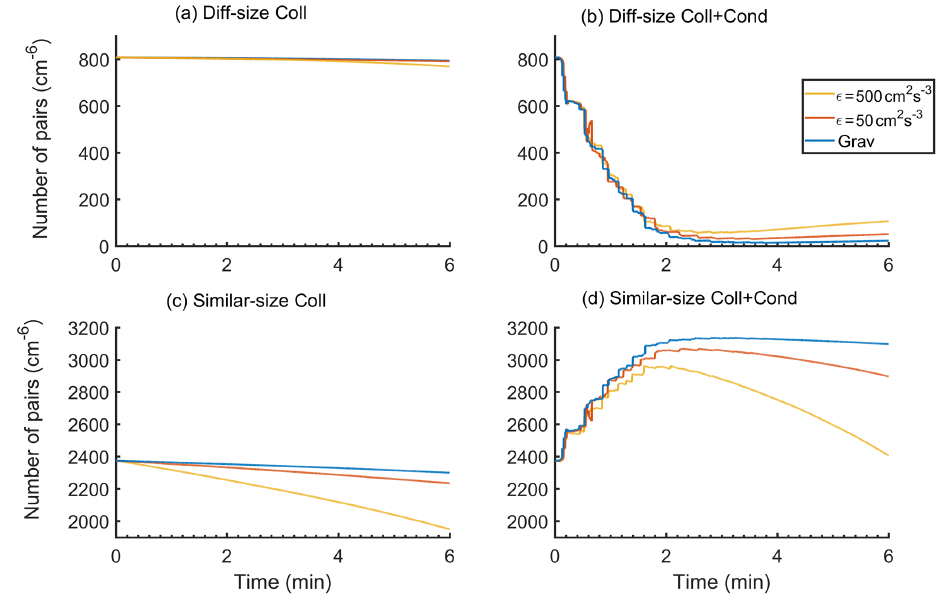
Figure 5. Time evolution of the number of pair combinations for (a) the different-sized droplets ( r/R ≤ 0 . 7) and (c) the similar-sized droplets ( r/R > 0 . 7) in the collision-only experiments, and (b) the different-size droplets and (d) the similar-sized droplets in the condensation– collision experiments. The pair combination is computed using the droplet number concentration (cm − 3 ); therefore, the unit is in cm − 6 . The color denotes the three different flow conditions which are shown in the